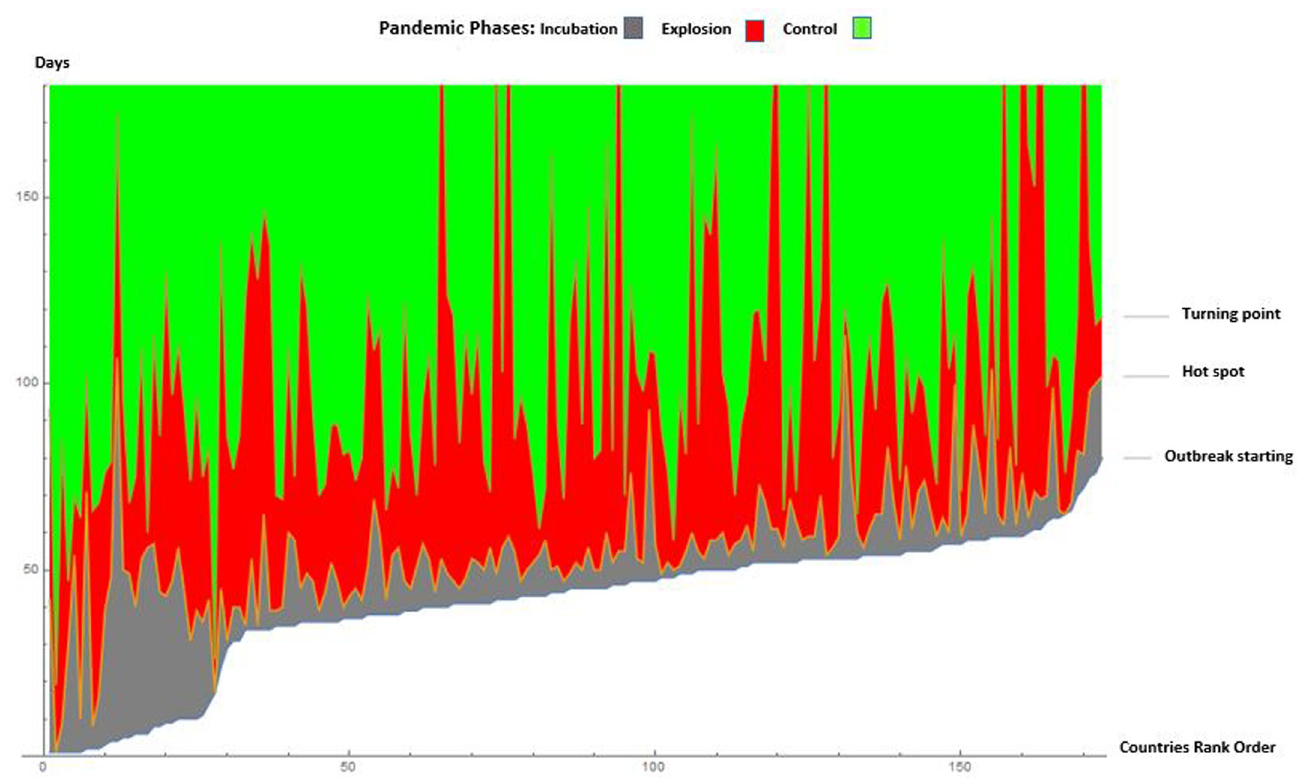
Fig 13. Phase changes caused by the evolution of the virus. In black the incubation phase, in red the explosion phase of the infected and in blue the control phase. The borders between the regions represent the date of the first infection, the second the date of the beginning of the hot spot and the third the date of the turning point, referred to each